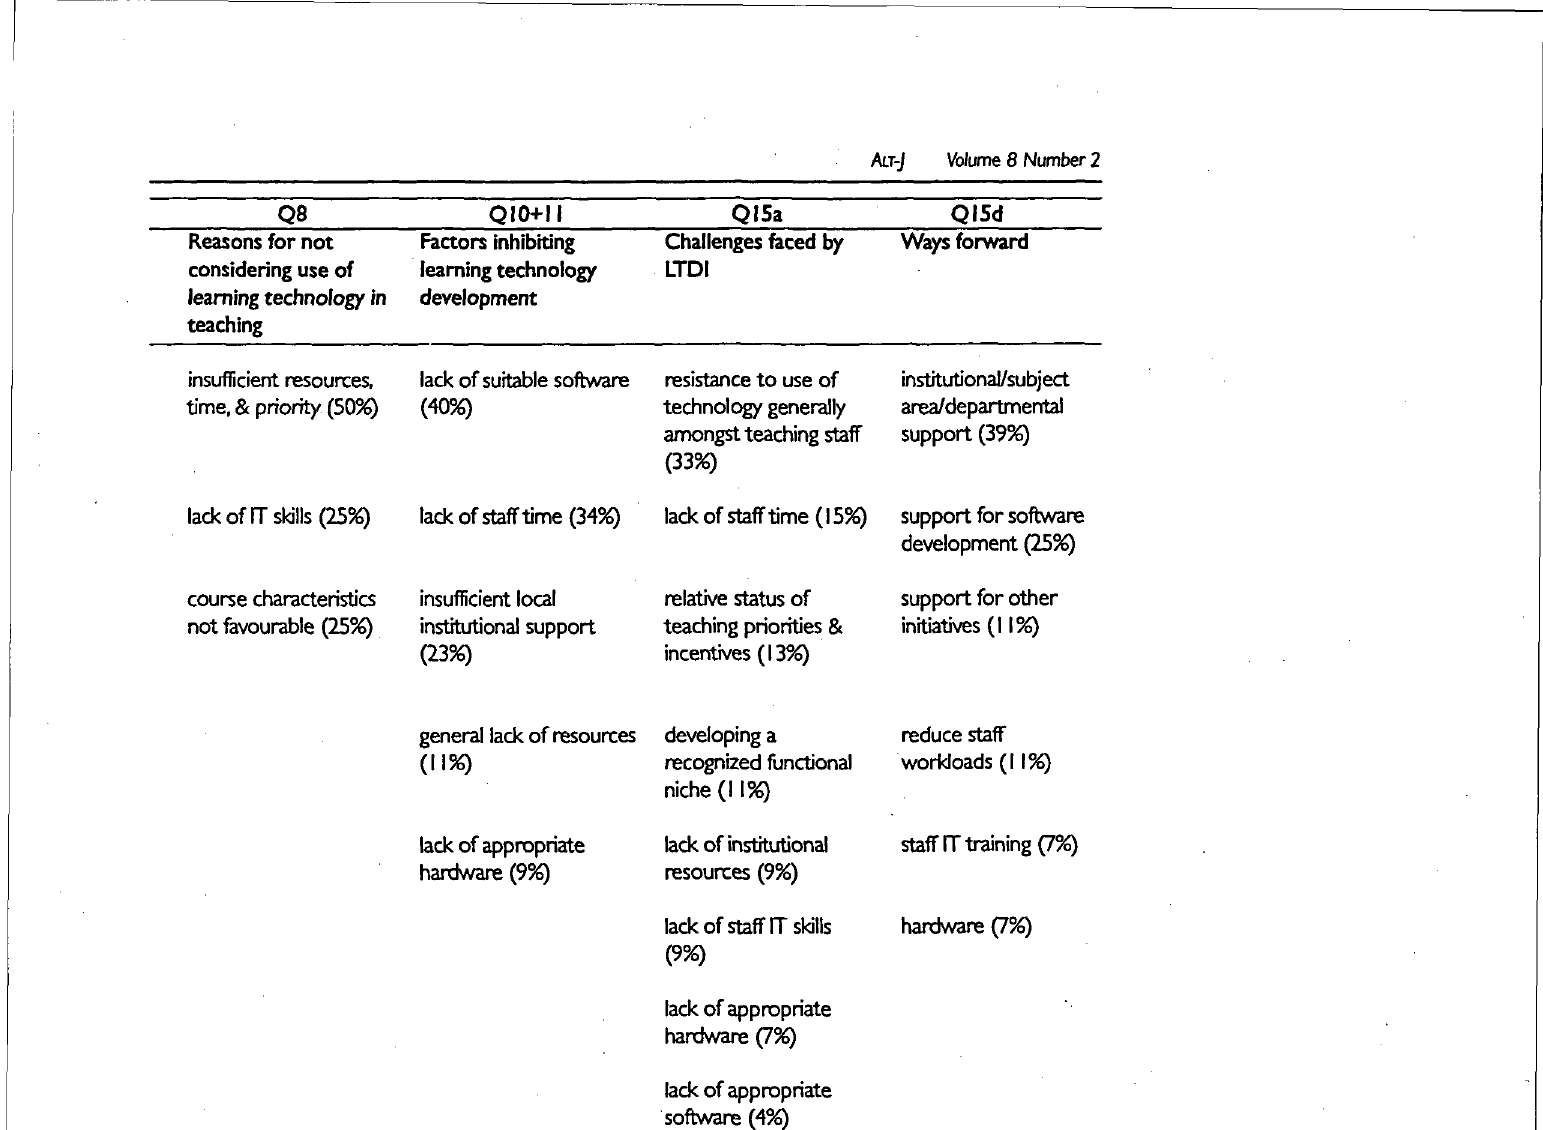
Table 3: Themes present in open-ended responses to selected questions in the academic staff questionnaire. Values in parentheses are the percentages of comments which contained each